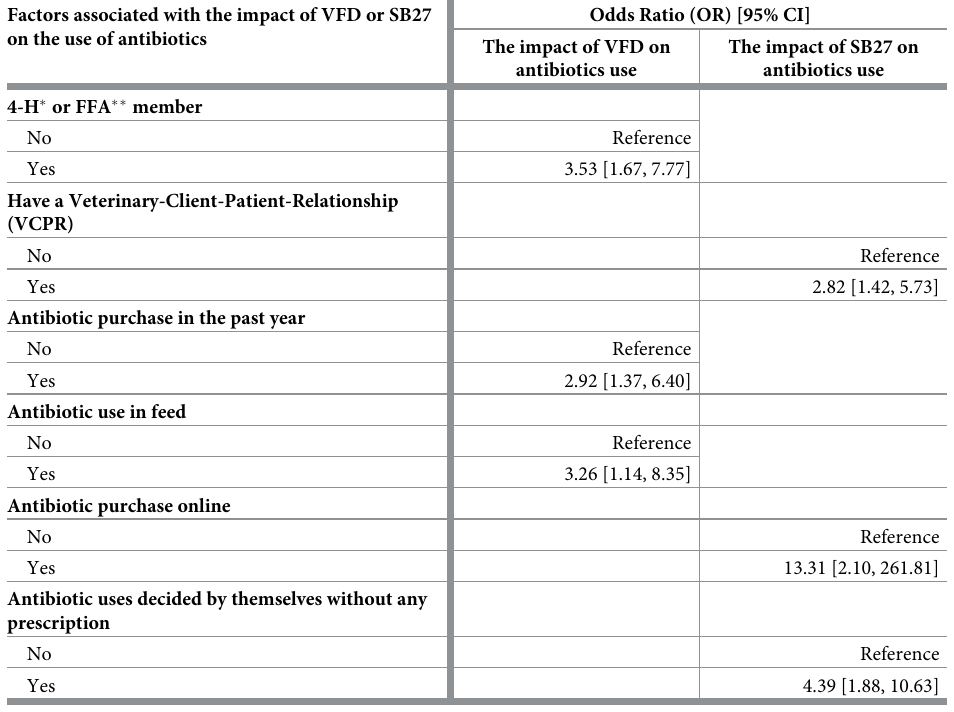
Table 6. Results of the multivariable logistic regression models about the impact of veterinary feed directive (VFD) and Senate Bill 27 (SB27) on the use of antibiotics. Factors associated with the impact of VFD or SB27 on the use of